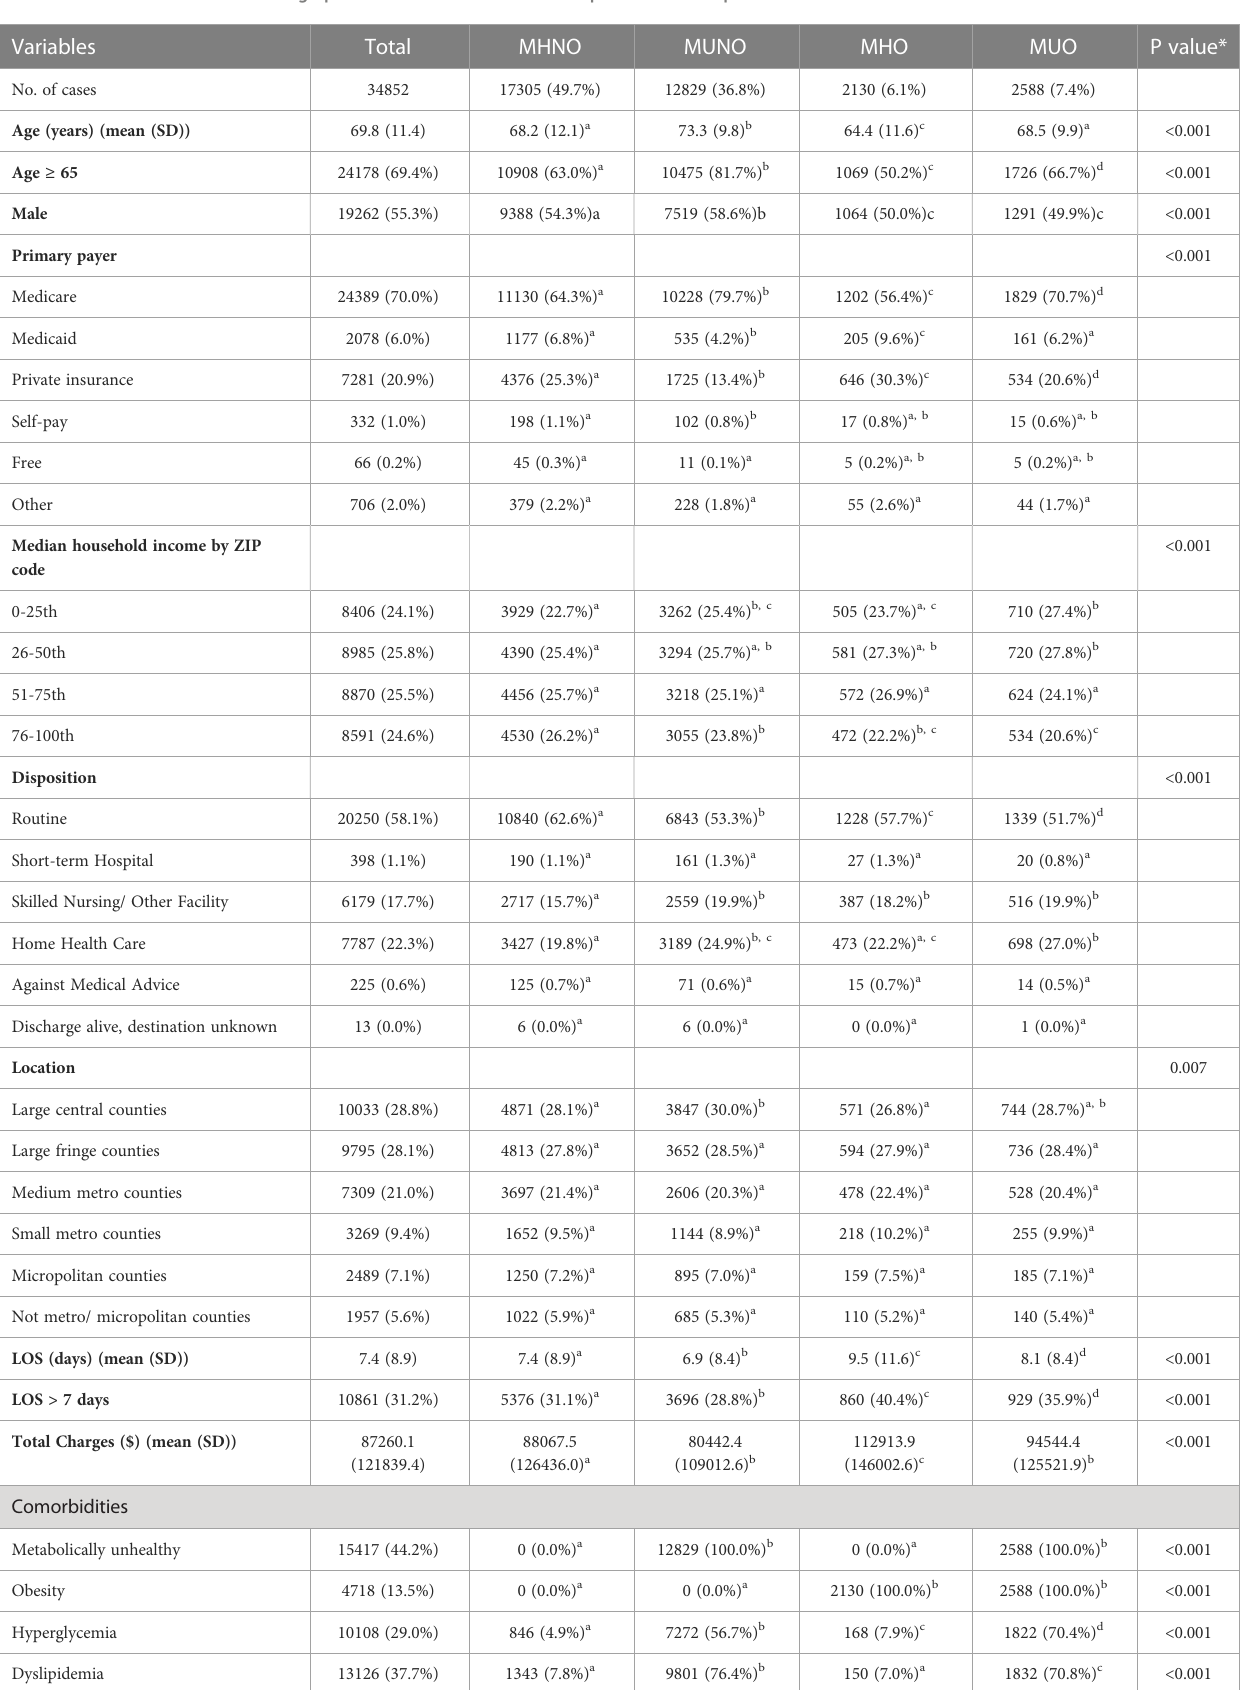
TABLE 1 Baseline clinical and demographic characteristics of index hospitalizations for